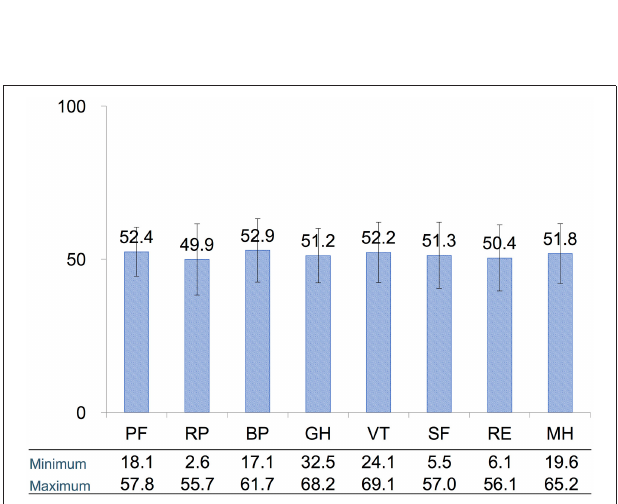
FIGURE 2 | Distribution of average scores for each of the eight SF-36 domains assessing QoL. All domain scores were within the norm-based average score for each domain. PF, physical functioning; RP, role physical; BP, bodily pain; GH, general health; VT, vitality; SF, social functioning; RE, role emotional; MH, mental health. Error bars are